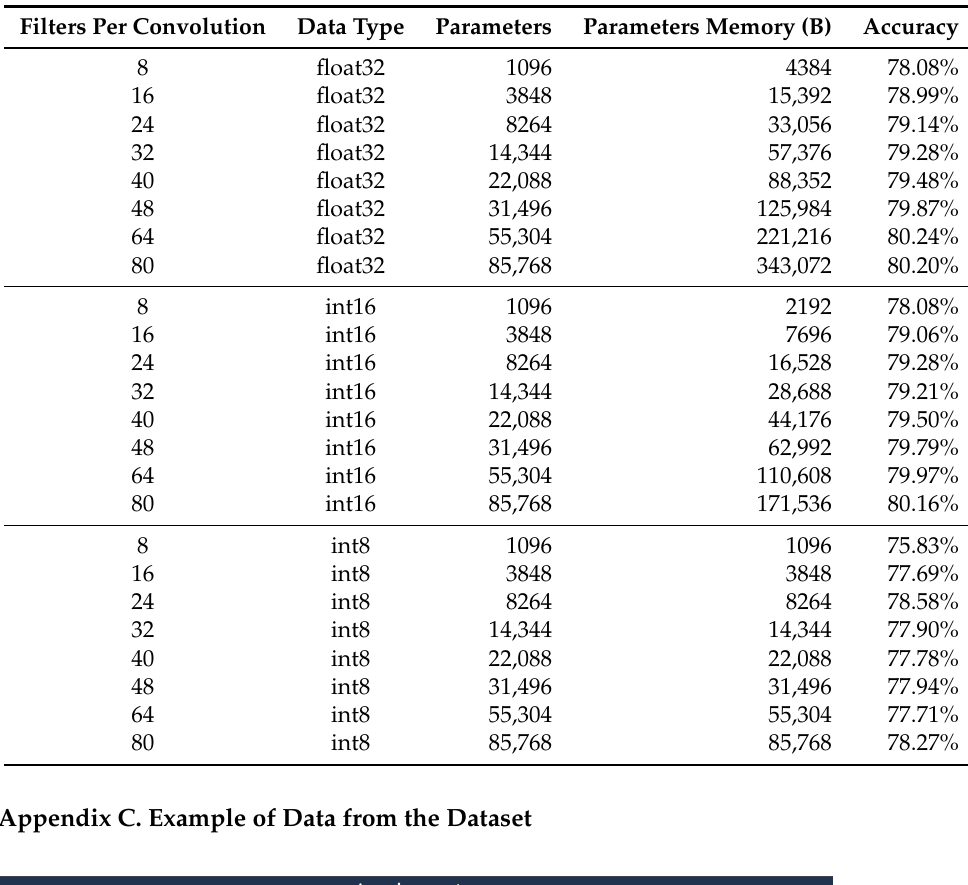
Table A2. Accuracy and parameters memory for each configuration of residual neural networks.